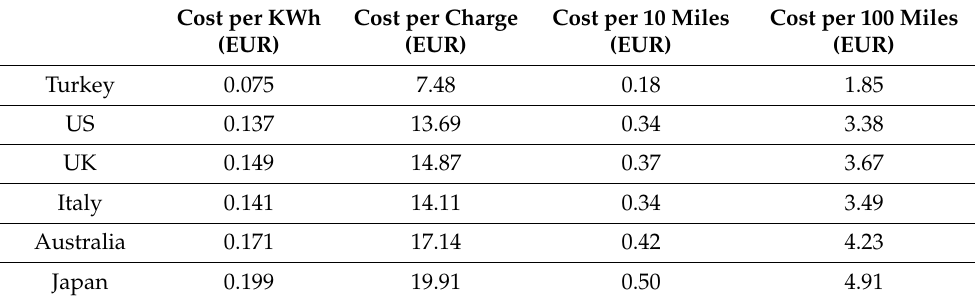
Table 2. Comparison of costs related to charging station